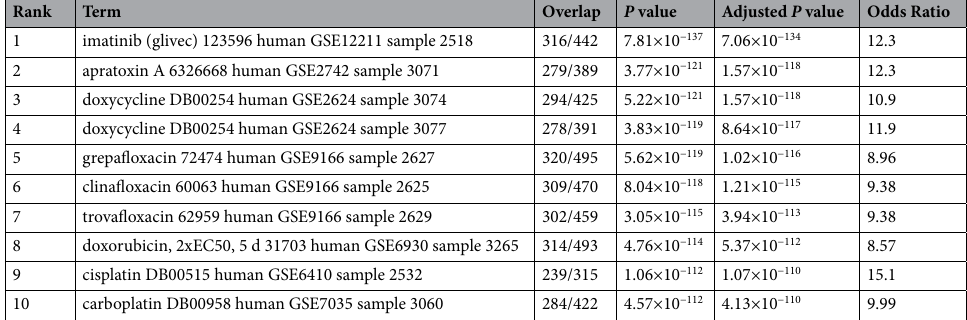
Table 4. Drug perturbations from GEO down.